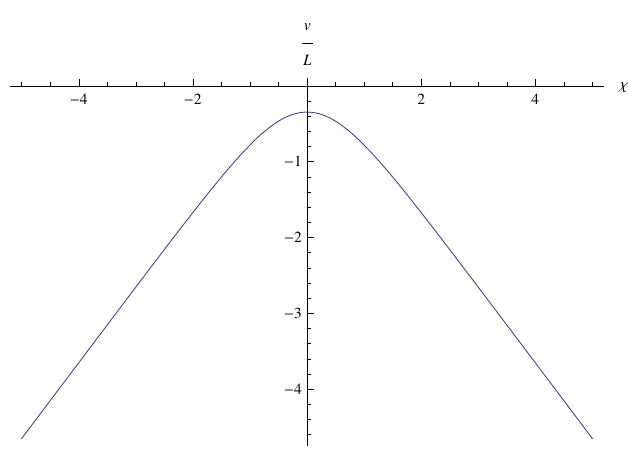
Figure 2 . The locus of points on the boundary where there are poles coming from one endpoint of the source trajectory. The specific values plotted are for the case where the source switches off precisely on the horizon, for which there are only v poles coming from the intersection of the past light cone of the endpoint with the hypersurface on which the CFT